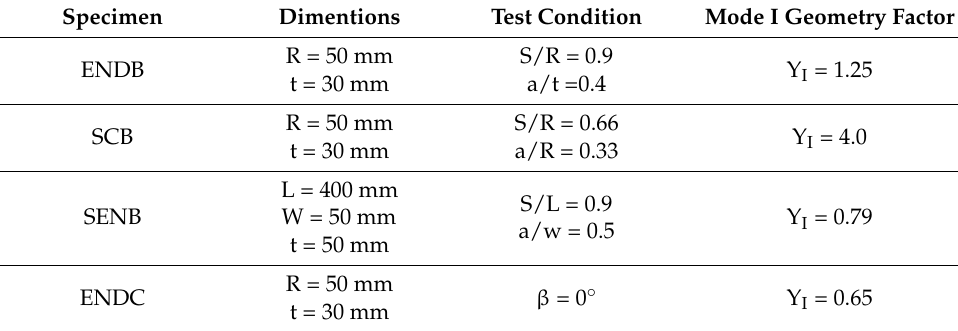
Table 4. Corresponding values of geometry factor (Y I ) for the investigated test